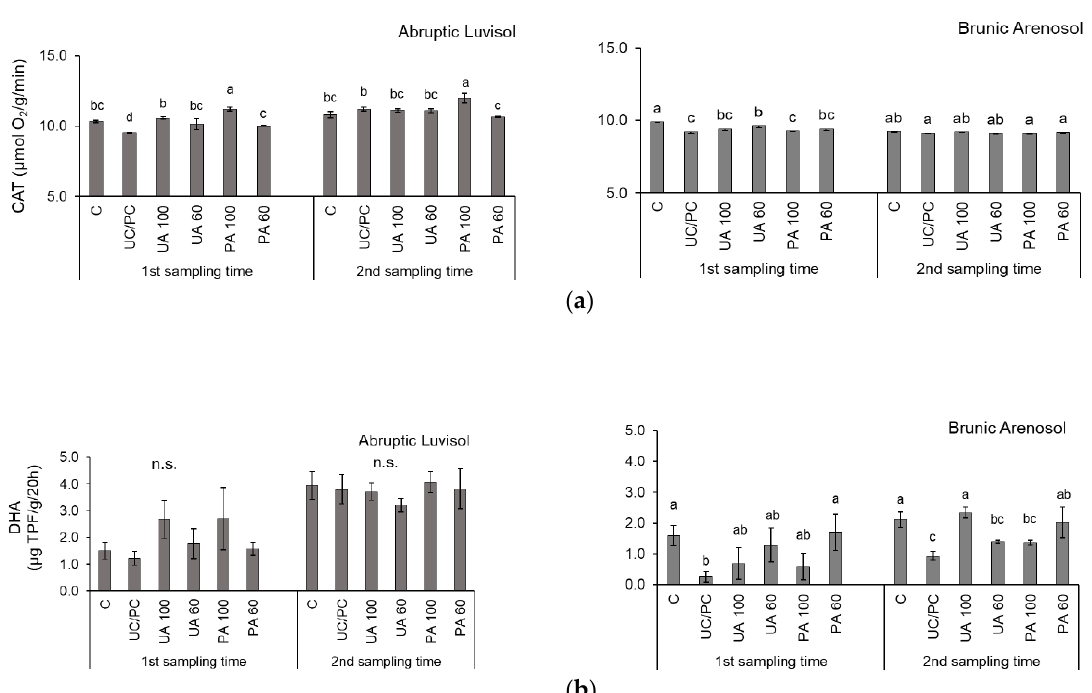
Figure 1. Enzymatic activity of ( a ) catalase (CAT) and ( b ) dehydrogenases (DHA) in Abruptic Luvisol and Brunic Arenosol collected on two dates after fertilization: I st sampling time (one week after the application of bio- and fertilizers), and II nd sampling time (six months after fertilization). Tested variants: C—control without fertilization, UC / PC—Polifoska and urea, UA 100—urea in full dose enriched with microorganisms, UA 60—urea in reduced dose enriched with microorganisms, PA 100—Polifoska in full dose enriched with microorganisms, PA 60—Polifoska in reduced dose enriched with microorganisms (average values ± standard deviation; n = 3). Di ff erent letters indicate significant di ff erences; n.s.—not significant; ANOVA, Tukey HSD test, separately for each soil and for each sampling time, p < 0.05 .